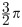
Simulation data were generated by Von-Mises Coupling.(a) From top panel to bottom panel: a 5Hz slow oscillation; a 40Hz fast oscillation; a 40 Hz fast oscillation, whose amplitude was modulated by the phase of 5Hz slow oscillation; Simulation data without noise; simulation data with noise (σ = 0.1). (b) Simulation data with different absolute amplitude levels of fast rhythm. The parameter c was increased from 0.5 to 1.5. (c) Simulation data with different modulation phases. The parameter θ0 was changed from 0π to 32π.